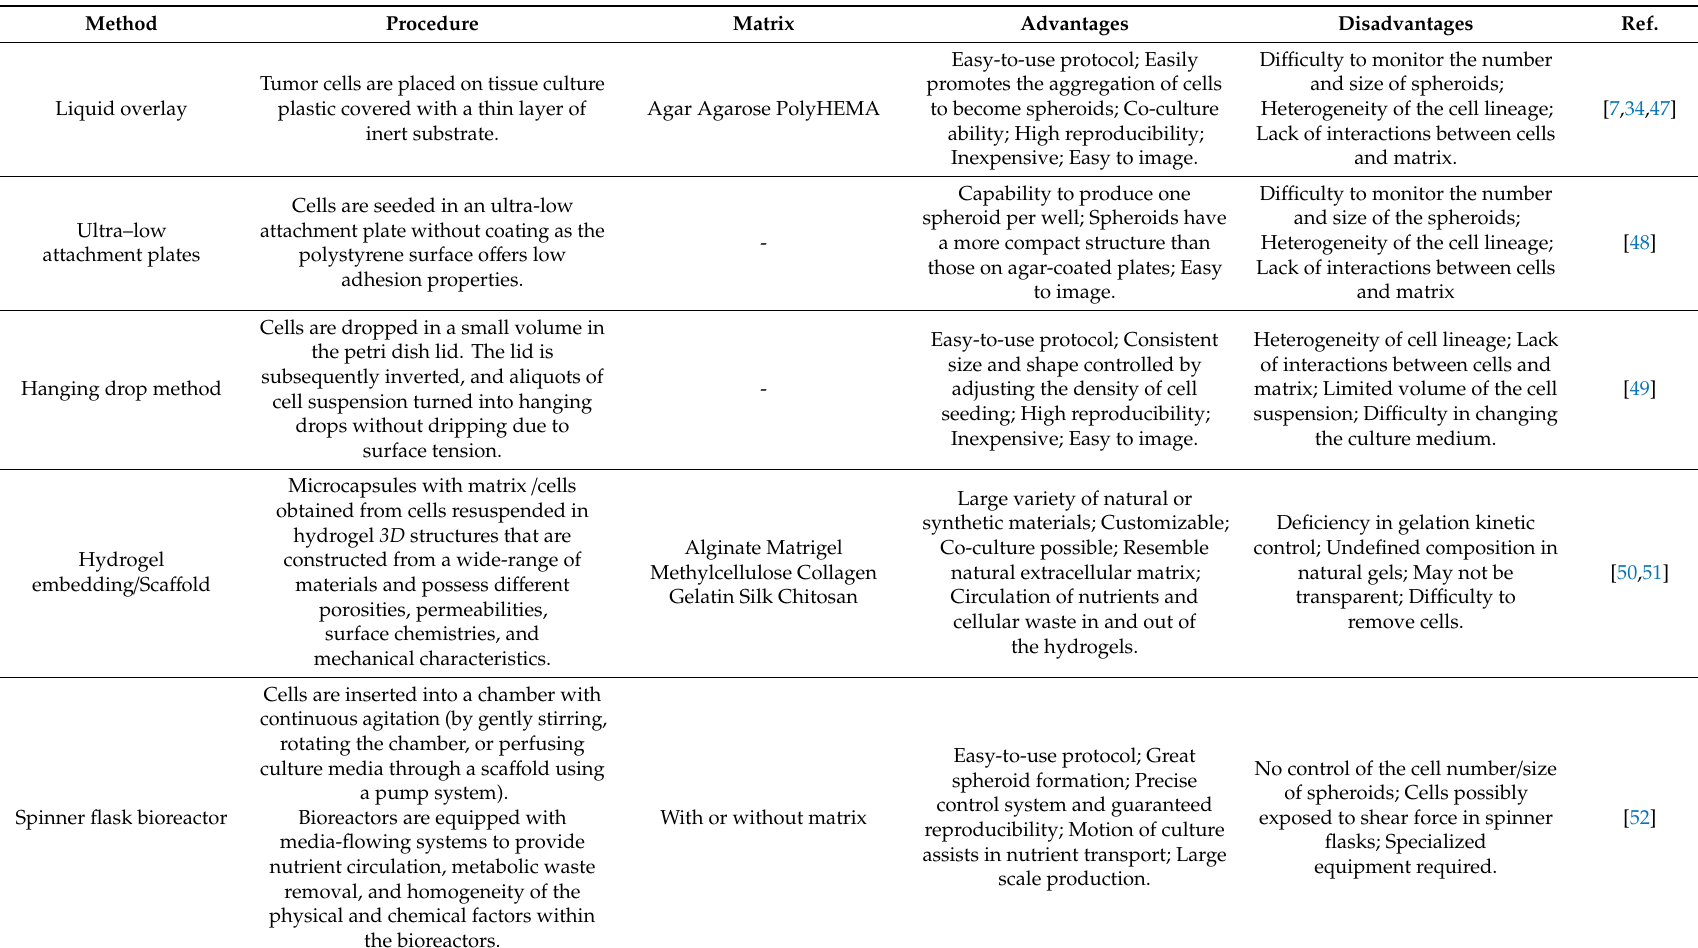
Table 2. Main methods used to generate